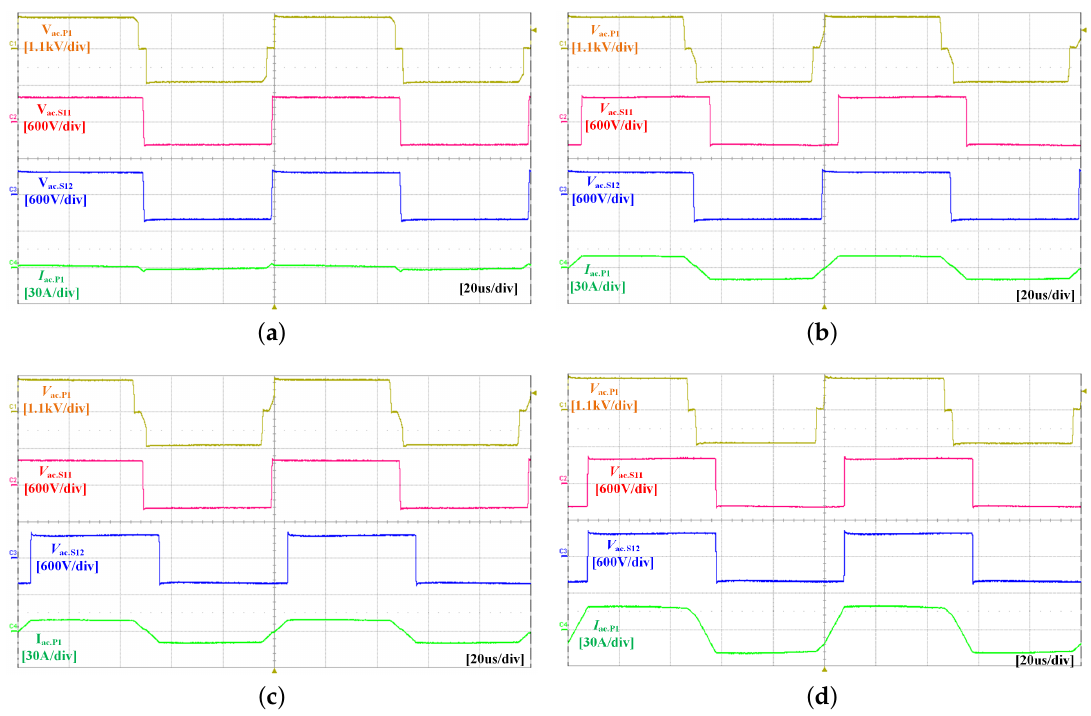
Figure 16. Steady-state waveform of a TAB converter: ( a ) under the no load condition; ( b ) when the amount of power transferred from port 1 to load is 7.5 kW; ( c ) when the amount of power transferred from port 2 to load is 7.5 kW; ( d ) when the amount of power transferred from each port to load is 7.5 kW.